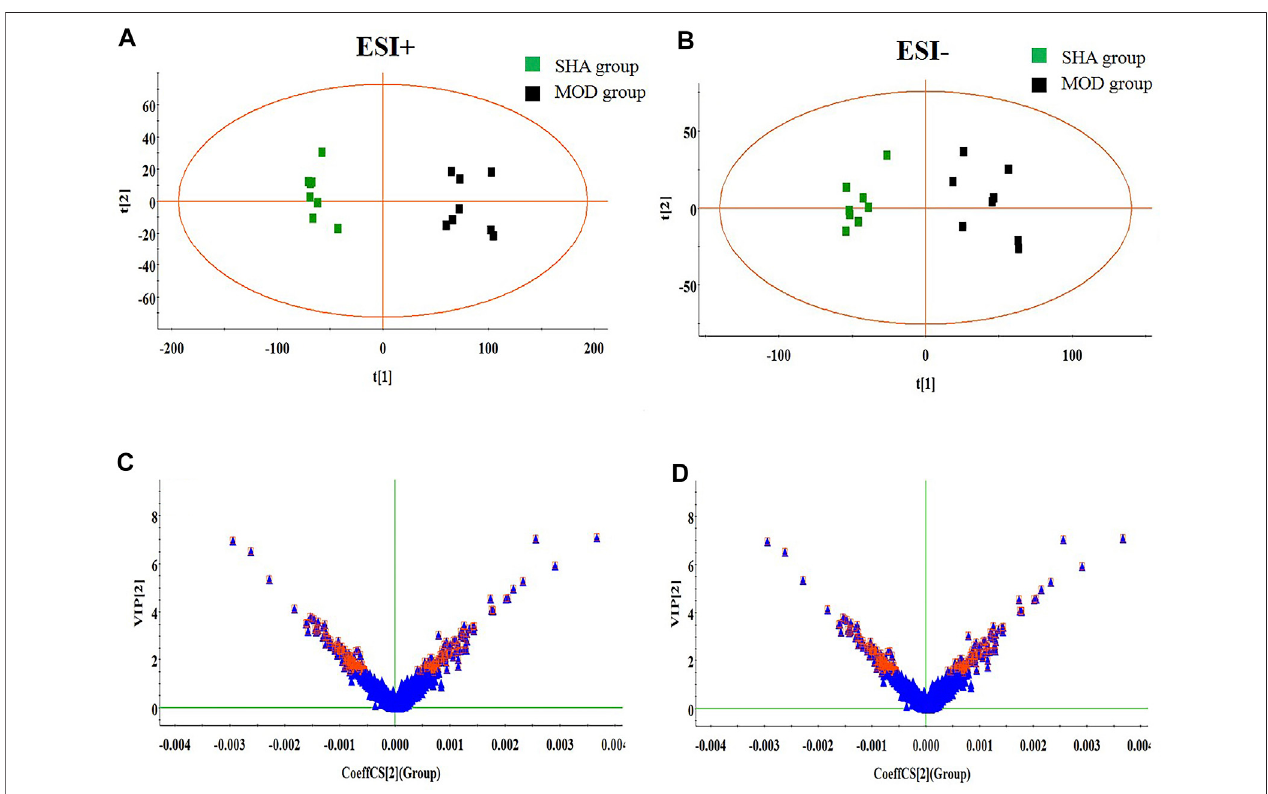
FIGURE 2 | OPLS-DA score plot and VIP-plot between the SHA and MOD groups ( n = 8 in every group). (A) and (C) are in positive ion mode; (B) and (D) are in negative ion